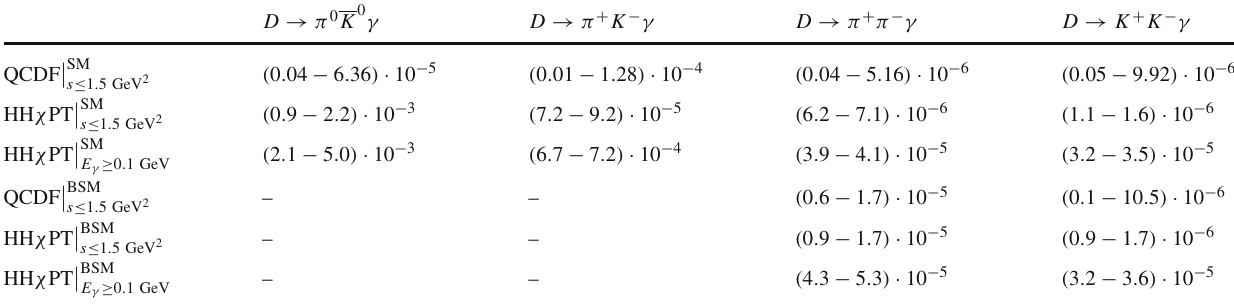
Table 1 SM and BSM branching ratios for D → π 0 K 0 γ , D → π + K − γ , D → π + π − γ and D → K + K − γ . QCDF is applicable